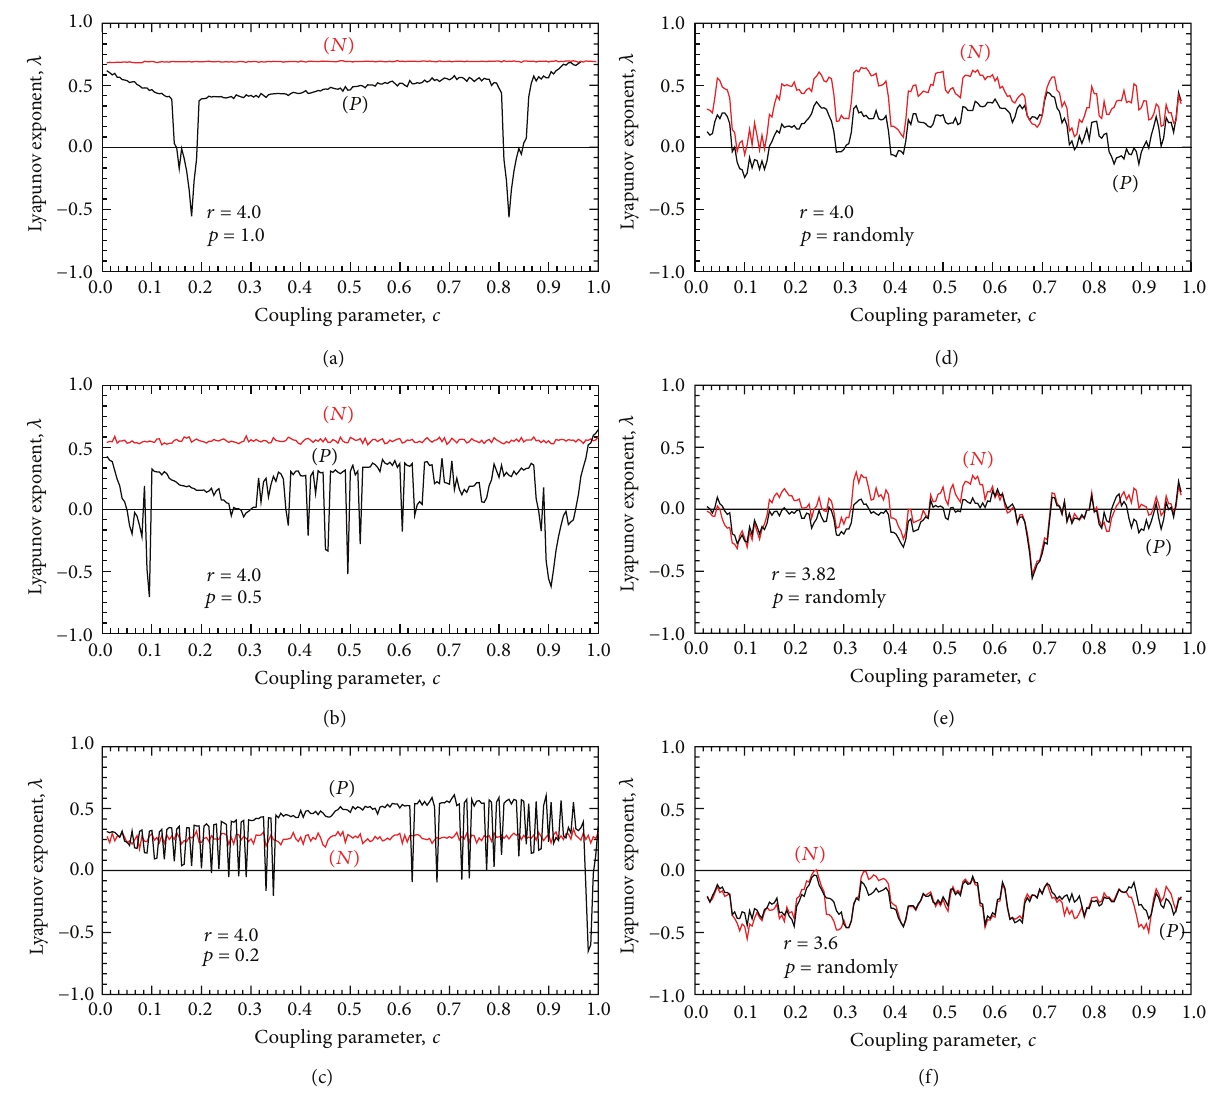
Figure 5: Diagram of Lyapunov exponent, 𝜆 , against coupling parameter 𝑐 for the fluctuated active coupling defined by (18a)–(18d) with 𝑃 (black line) compared to passive coupling and 𝑁 (red line) for different values of parameter of exchange 𝑝 and logistic parameter 𝑟 . In (a)–(c) 𝑝 takes the fixed values (1.0, 0.5, 0.2), while 𝑟 = 4 . In (d)–(f) 𝑝 is randomly chosen, while 𝑟 takes values 4.0, 3.82, and 3.6, respectively. Simulations were performed with the closed contour of 𝑁 = 100 environmental